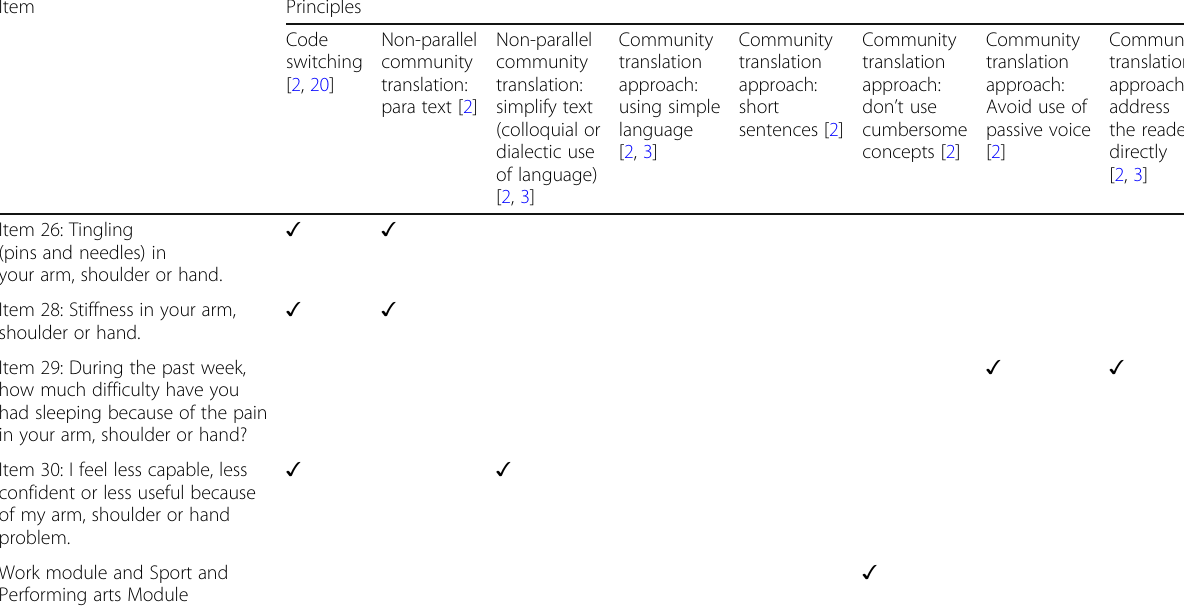
Table 2 Principles of community translations applied to test items (Continued)